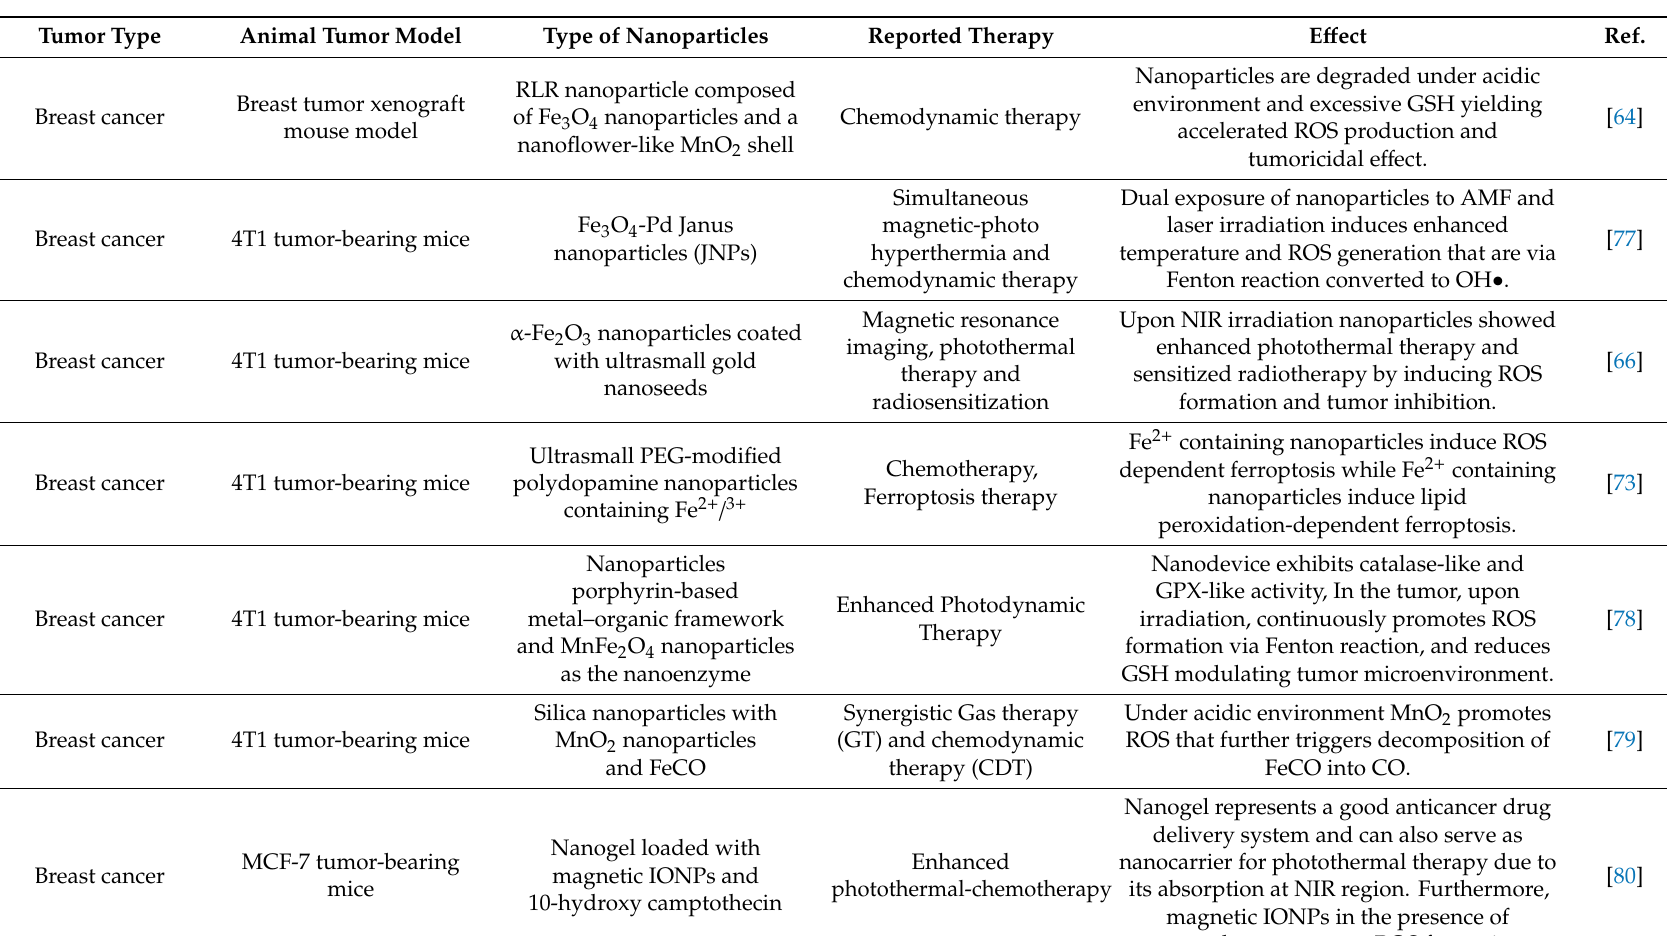
Table 1. Recent animal studies with variety of iron containing nanoparticles for cancer therapy by altering cellular redox